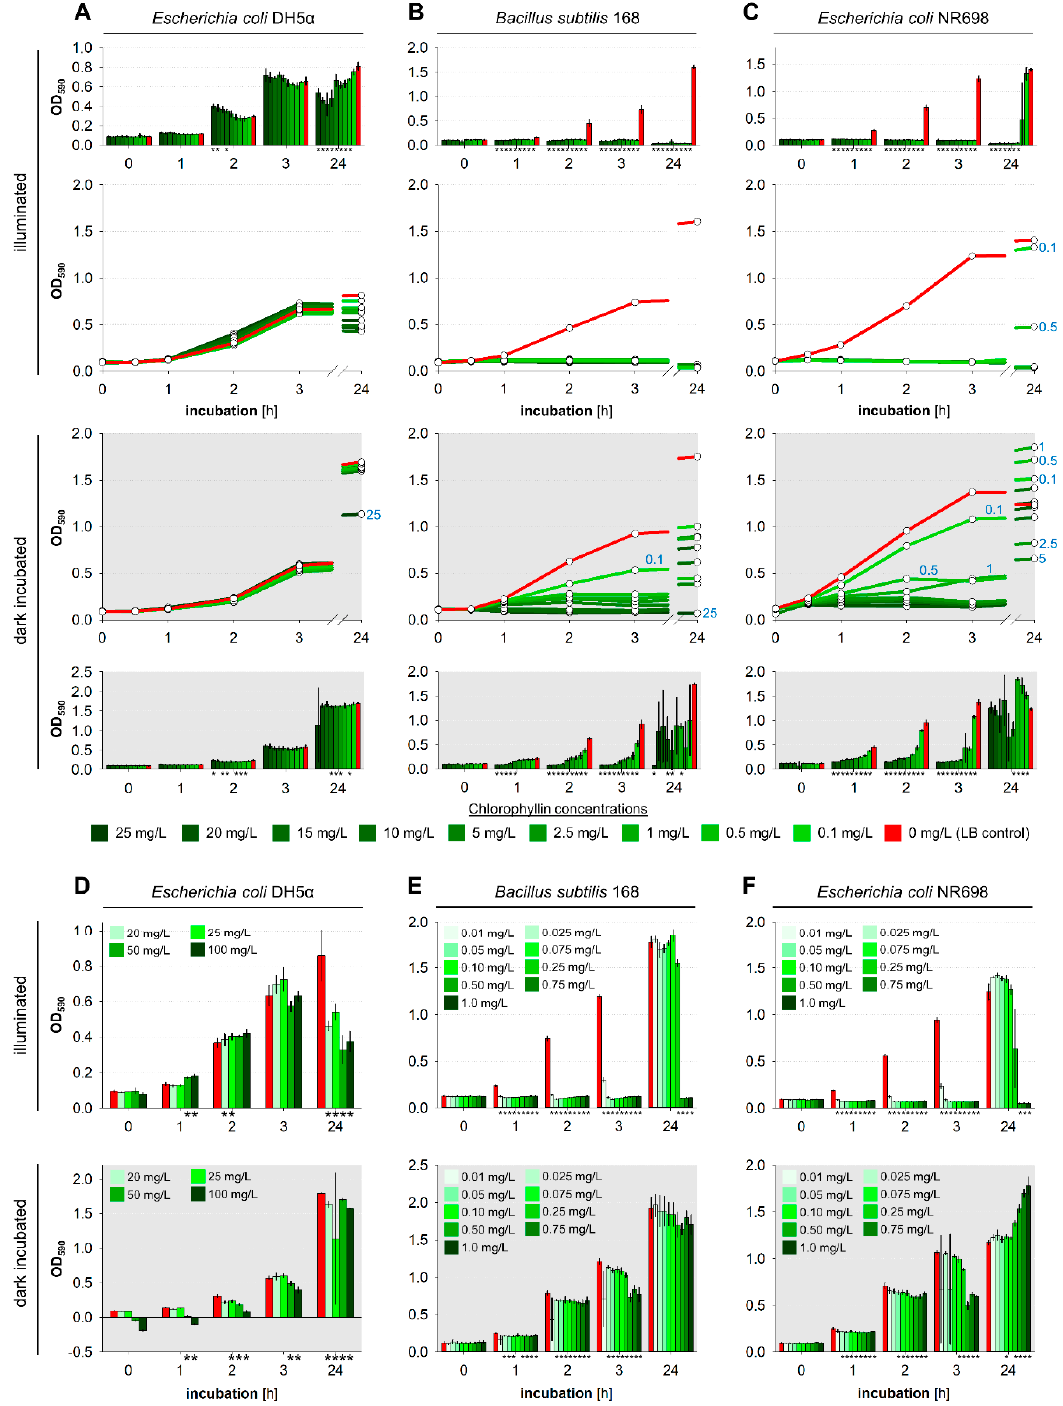
Figure 5. Influence of different chlorophyllin concentrations on the growth of ( A ) Escherichia coli DH5 α , ( B ) Bacillus subtilis 168 and ( C ) Escherichia coli NR698 (initial cell number: ~10 8 cfu/mL). Bacteria were cultured for 24 h at 37 ◦ C exposed to light (12 mW/cm 2 ; bright plots, upper row) or in darkness (grey plots, lower row). To determine the lower limit of efficacy, additional chlorophyllin concentrations were tested: ( D ) Escherichia coli DH5 α , 20 ↑ 100 mg/L ( E ) Bacillus subtilis 168, 1.0 ↓ 0.01 mg/L and ( F ) Escherichia coli NR698, 1.0 ↓ 0.01 mg/L. Depicted are means (growth curves) together with corresponding 95% confidence limits (bar charts). Blue numbers indicate respective chlorophyllin concentrations. * p < 0.05 vs. control culture without